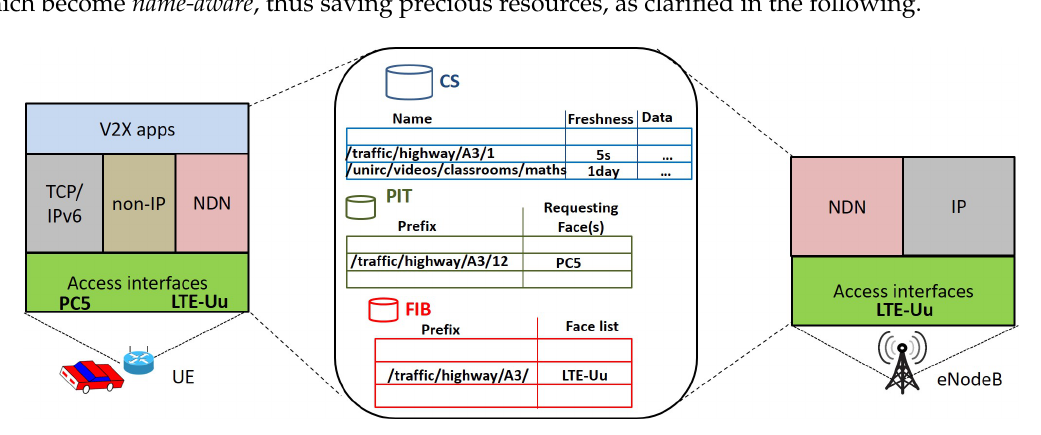
Figure 2. The NDN-based protocol stack for UE and